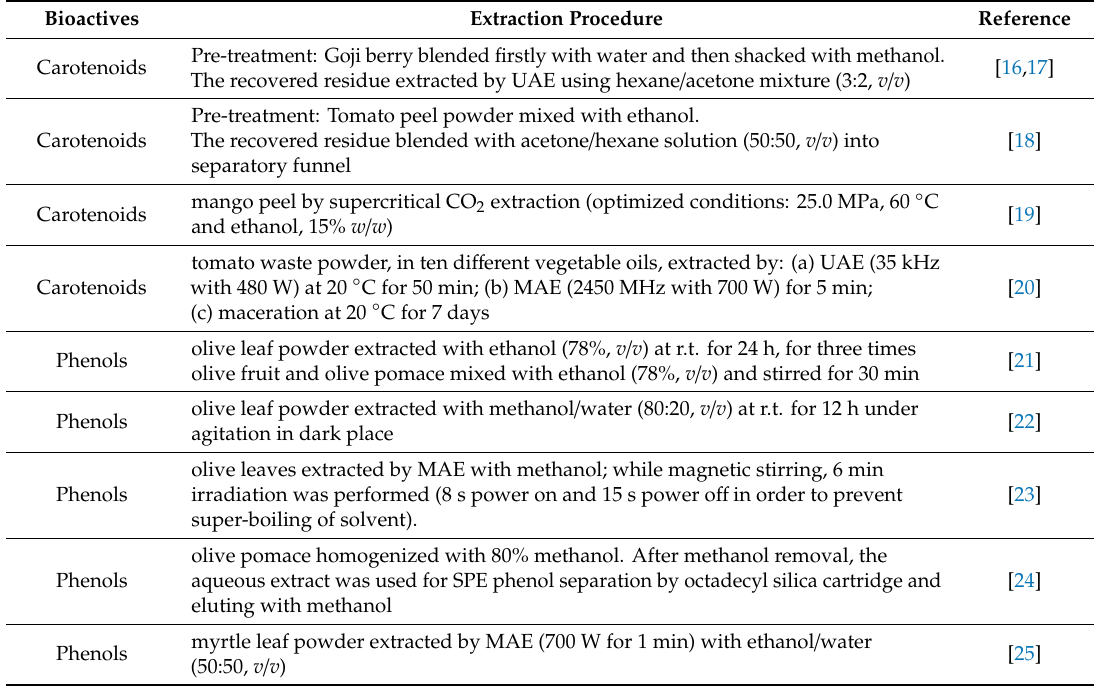
Table 1. Examples of extraction procedures of natural antioxidants used for the enrichment of oils. Bioactives Extraction Procedure Reference